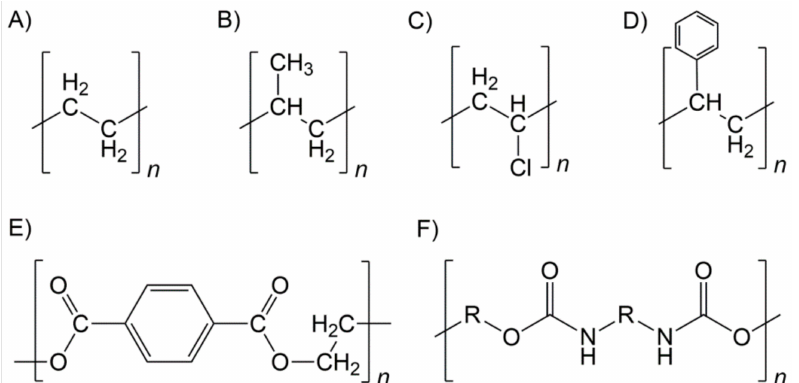
Figure 2. Chemical structures of polyethylene ( A ), polypropylene ( B ), polyvinyl chloride ( C ), polystyrene ( D ), polyethylene terephthalate ( E ) and polyurethane ( F